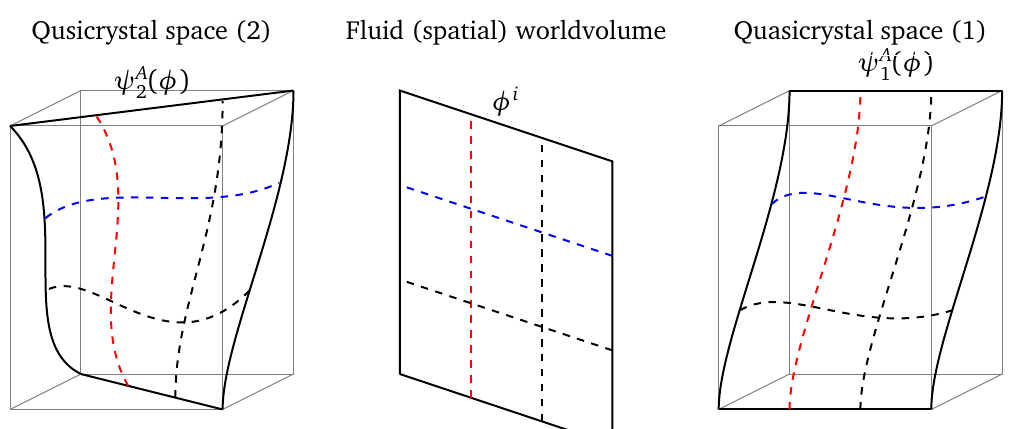
Figure 7: This figure depicts how, at fixed time φ 0 , the spatial submanifold of the fluid worldvolume is mappeed into two copies of the quasicrystal worldvolume with ( φ ) and ψ B ( φ ) . We suppress the φ 0 -coordinate as the qua- the embedding maps ψ A 1 1 sicrystal spaces have no intrinsic notion of time. Notice that unlike the mapping into physical spacetime, the quasicrystal dimension is greater than that of the spatial fluid